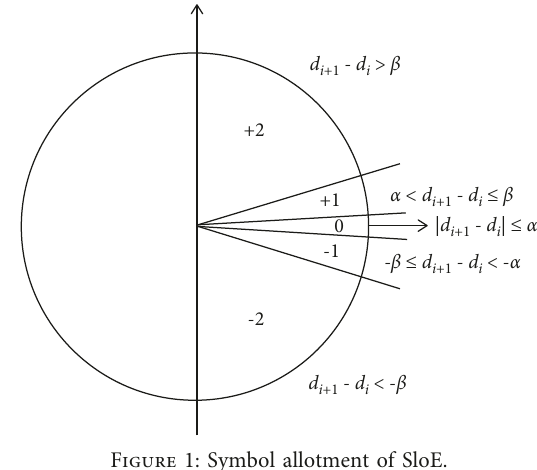
Figure 1: Symbol allotment of SloE.